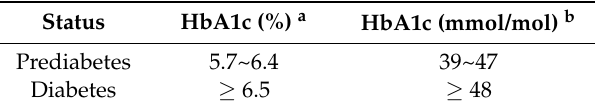
Table 1. ADA criteria for the diagnosis of diabetes and prediabetes based on